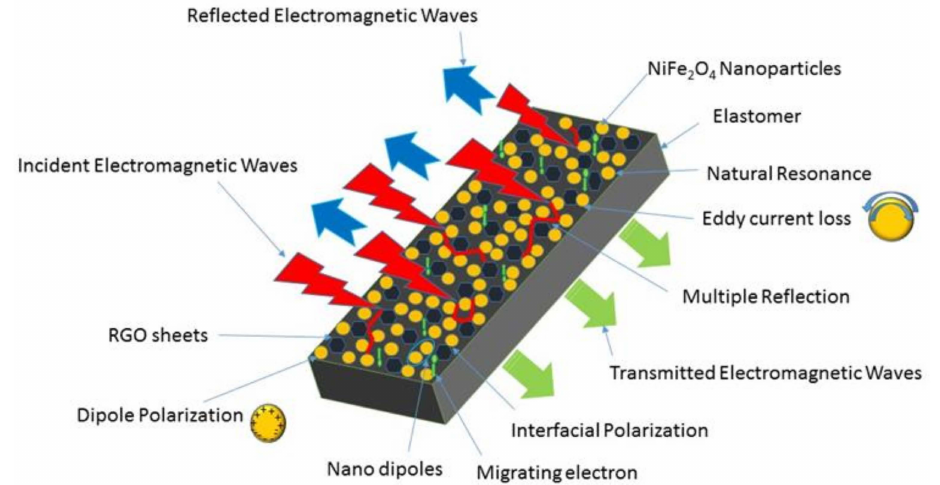
Figure 14. Schematic illustration of the possible mechanism of the electromagnetic wave shielding for polypropylene elastomer nanocomposites filled with spinel ferrite NiFe 2 O 4 nanoparticles with in-situ reduced graphene oxide